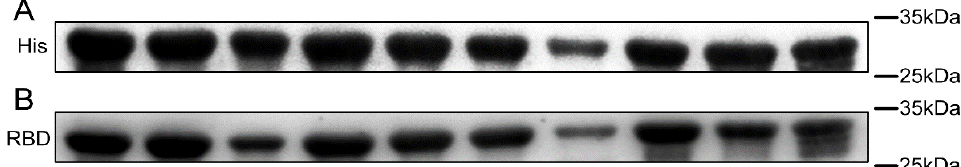
Figure 2. Western blotting analysis of RBD protein mutants. ( A ) His-tag mouse monoclonal antibody. ( B ) RBD human monoclonal antibody. The bands from left to right were wild RBD, K417T, K417N, L452R, E484K, E484Q, N501Y, L452R-E484Q, K417T-E484K-N501Y, and K417N-E484K-N501Y.